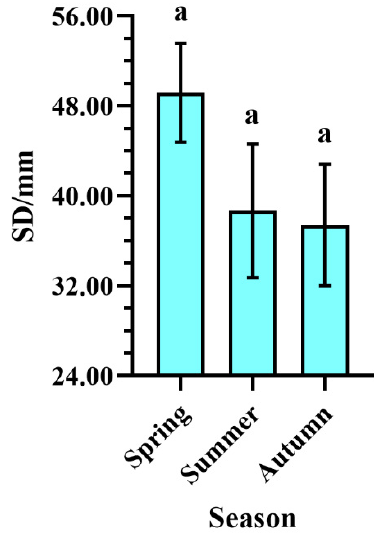
Fig 2 . Seasonal variation in the shortest distance ( SD ) between two adjacent swarm cells on the comb.